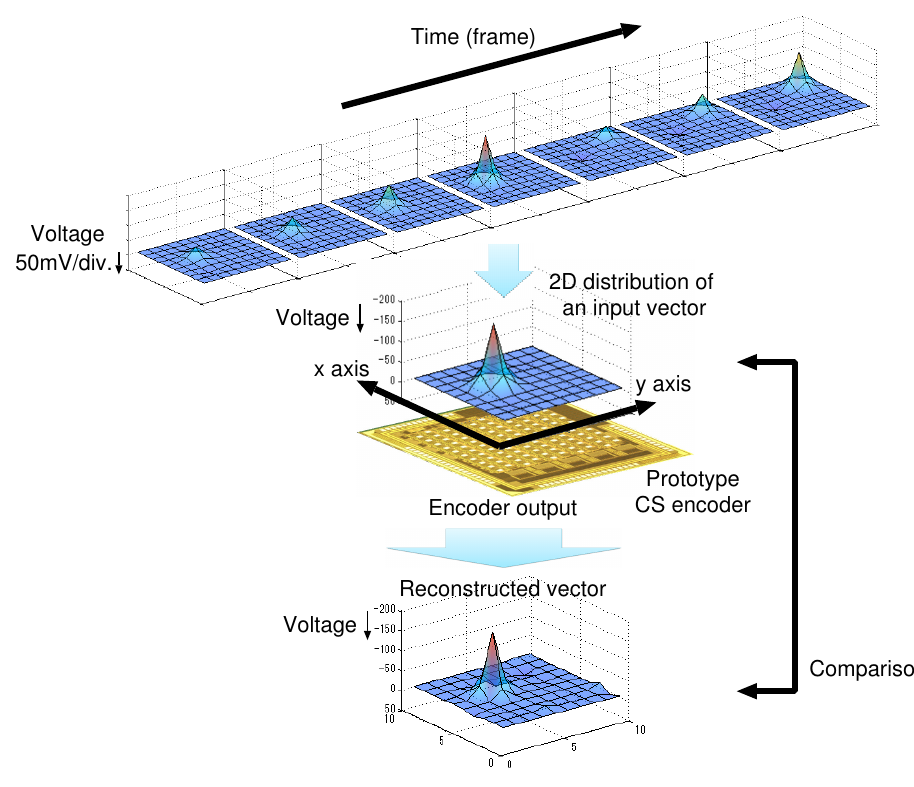
Figure 16. Evaluation procedure for the CS